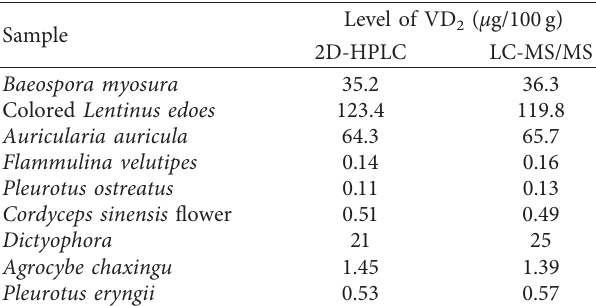
Table 4: The levels of VD 2 in 9 edible